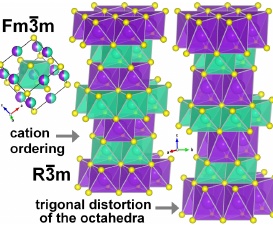
Figure 1. Cubic and rhombohedral modifications of ALnS 2 sulfides. Yellow atoms: S 2 − ; green atoms: Ln 3+ ; pink atoms: A + . Table 1. Octahedral ionic radii of the relevant ions.